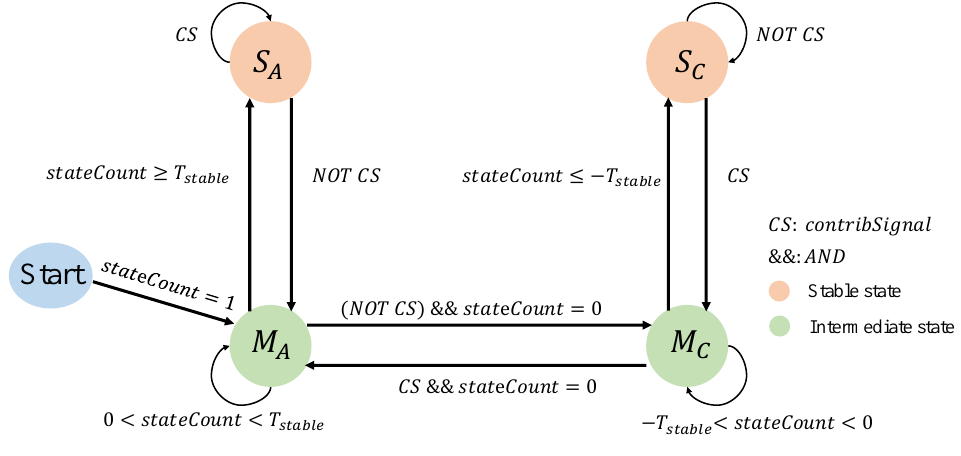
Figure 3. The Example of State